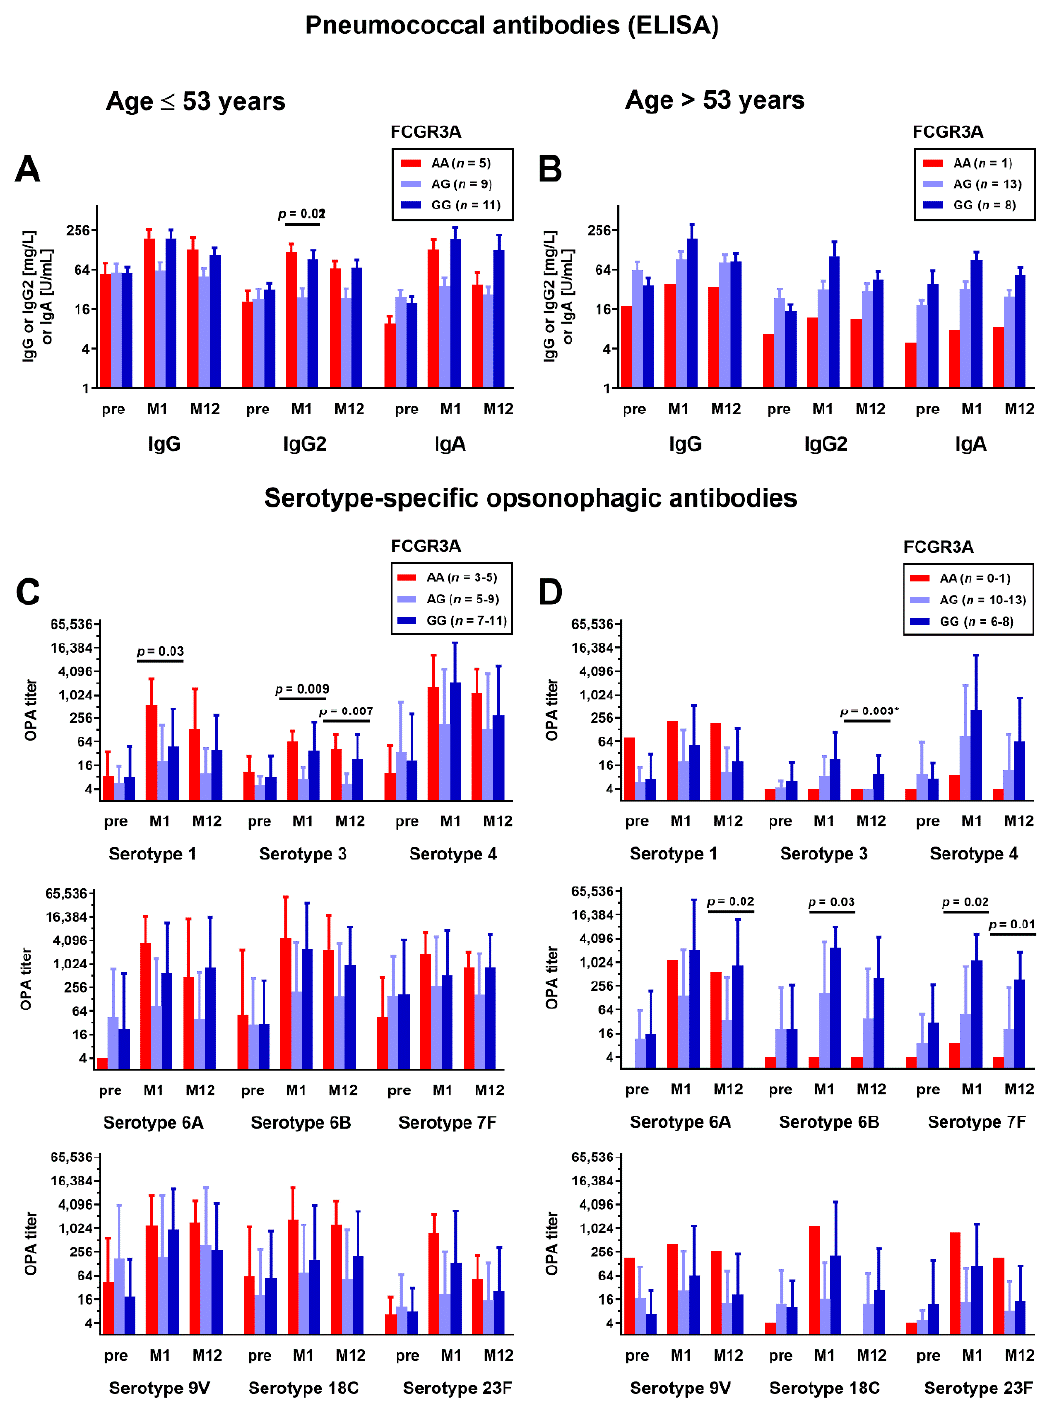
Figure 3. Kidney transplant recipients were genotyped for the FCGR3A rs396991 polymorphism and antibodies determined by commercial ELISA ( A , B ), and serotype-specific opsonophagocytic antibody (OPA) responses ( C , D ) were divided by genotype and age group. The left panels show data in younger patients ( ≤ median age of 53 years), while the right panels show data in older patients (>53 years). Antibodies were determined prior to pneumococcal vaccination (pre) and at month 1 (M1) and month 12 (M12) thereafter. The results are shown on a logarithmic scale (log2) as geometric means and geometric standard deviation factors [39] . The three genotype groups were compared by Kruskal–Wallis test with Dunn’s multiple comparisons test. The results that remained significant after Bonferroni correction are marked with an